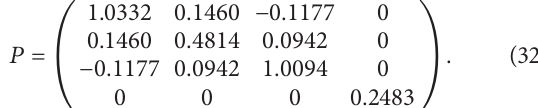
Figure 2. Note that the network is successfully pinned to a homogenous